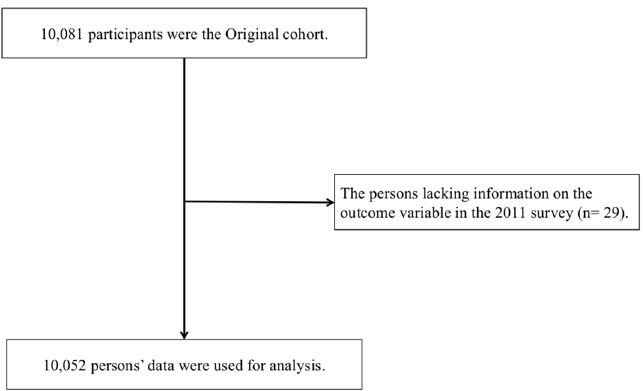
Figure 3. Flow chart of the procedure for selecting patients. Out of 10,081 people in the original cohort, we excluded 29 persons who lacked information on outcome variables in the 2011 survey. Data for 10,052 participants were used for